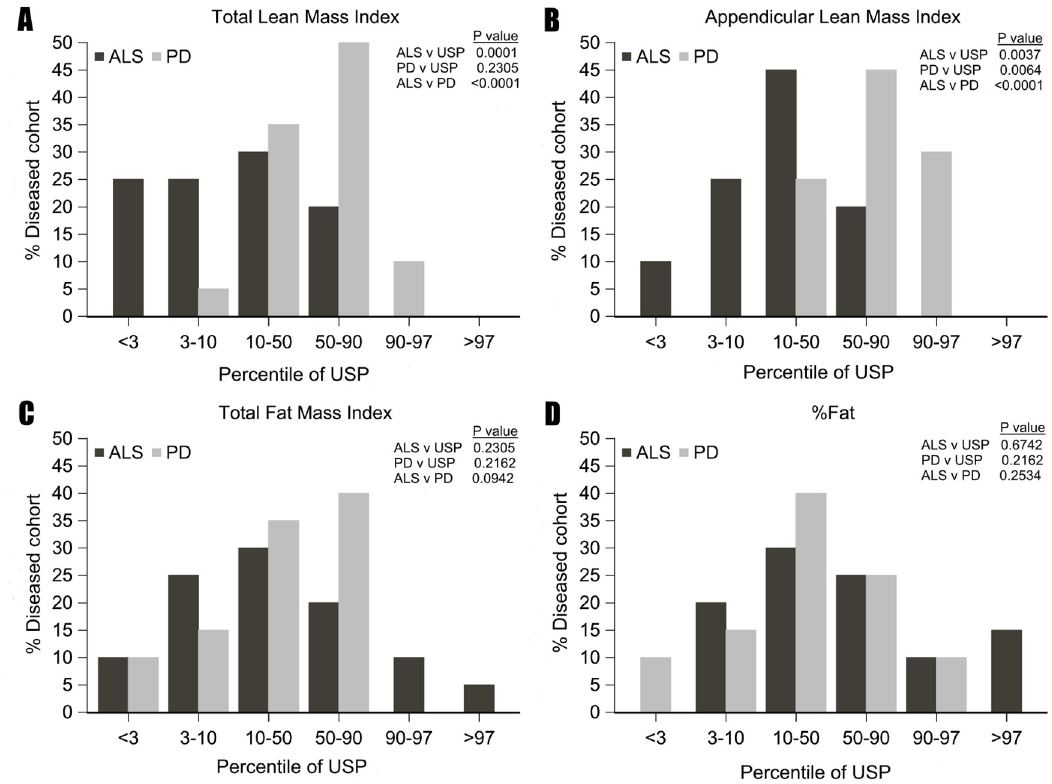
Fig 1. Percentile distribution of ALS and PD cohorts at enrollment based on z scores compared to age, sex and race matched United States Population (USP). The ALS cohort had significantly lower total lean mass index (A) and appendicular lean mass index (B) compared to the PD cohort and USP. The PD cohort had significantly higher appendicular lean mass compared to USP (B). Total fat mass index (C) and percent fat (D) were not different between ALS and PD cohorts and USP. P-values are derived from Wilcoxon signed-rank test of ALS cohort vs USP, PD cohort vs USP, and from Wilcoxon rank-sum test of ALS cohort vs PD